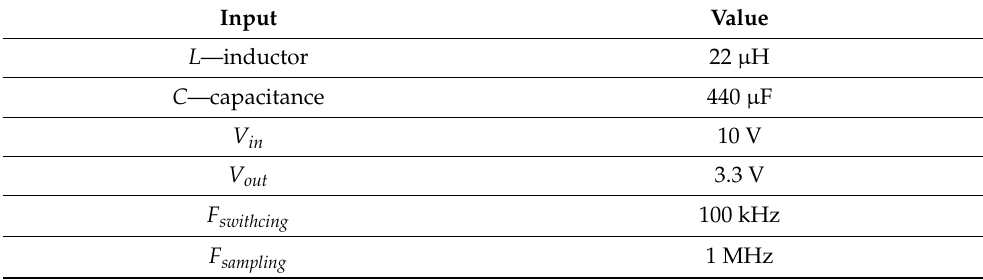
Table 4. Buck power stage parameters.